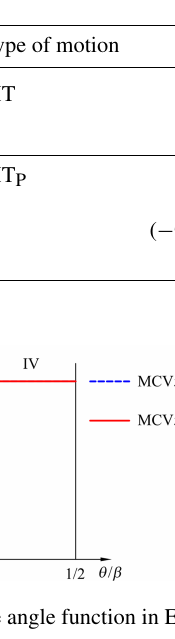
Table 4. Motion characteristics of MT P and MT.